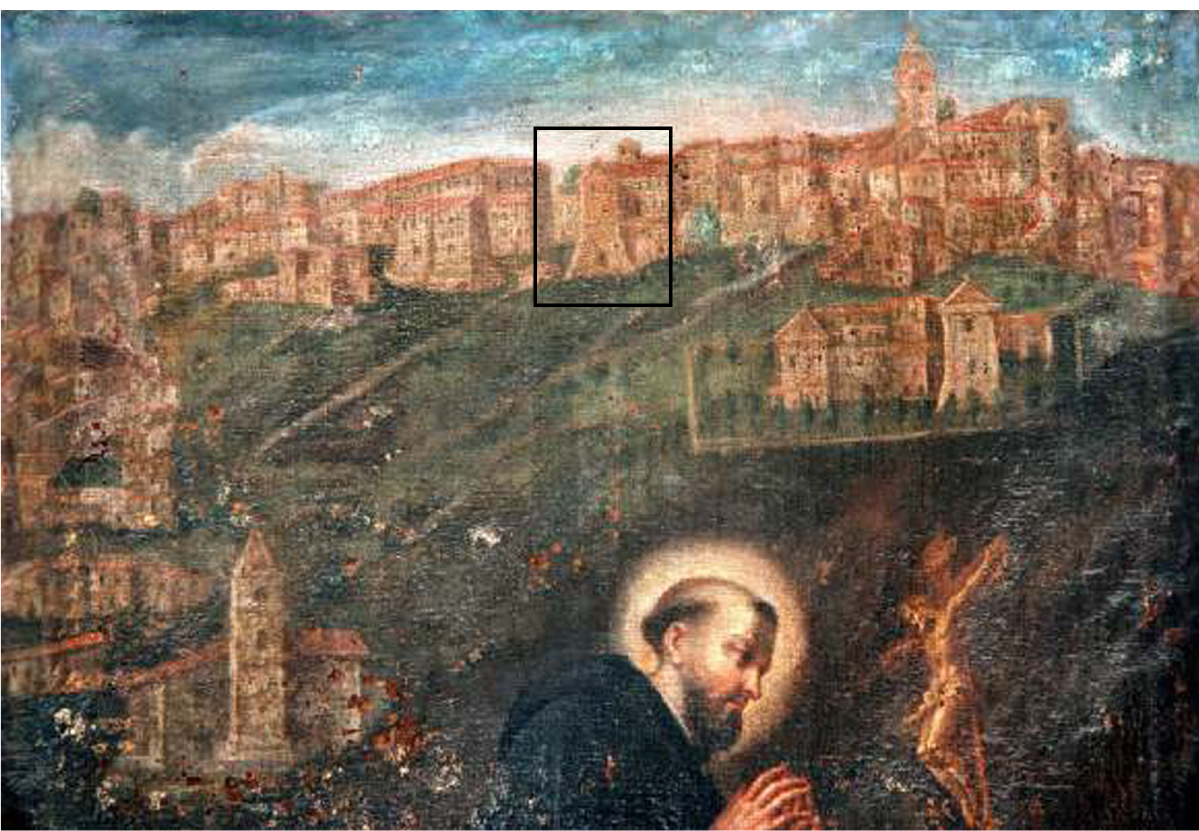
Fig. 1: Representation of the town of Troina in 1700. The image illustrates the south-eastern tower facade of the Convent. San Silvestro Monaco da Troina orante , oil on canvas, c.